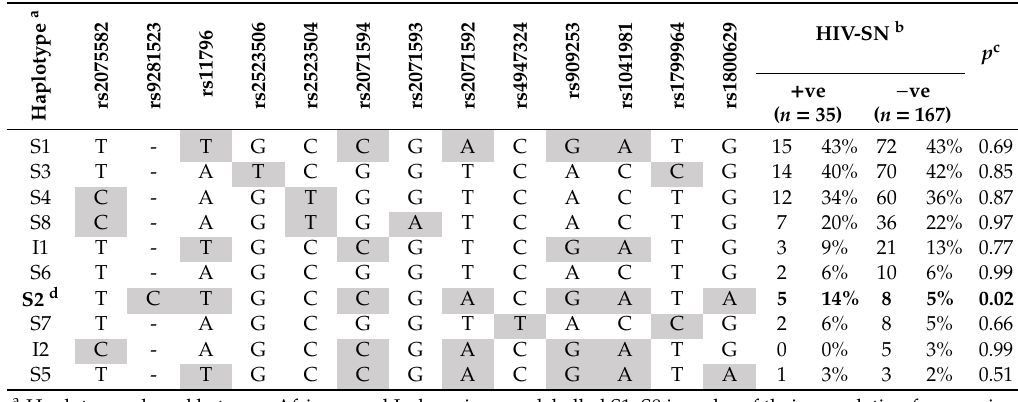
Table 5. One haplotype associated with HIV-SN in Indonesians.